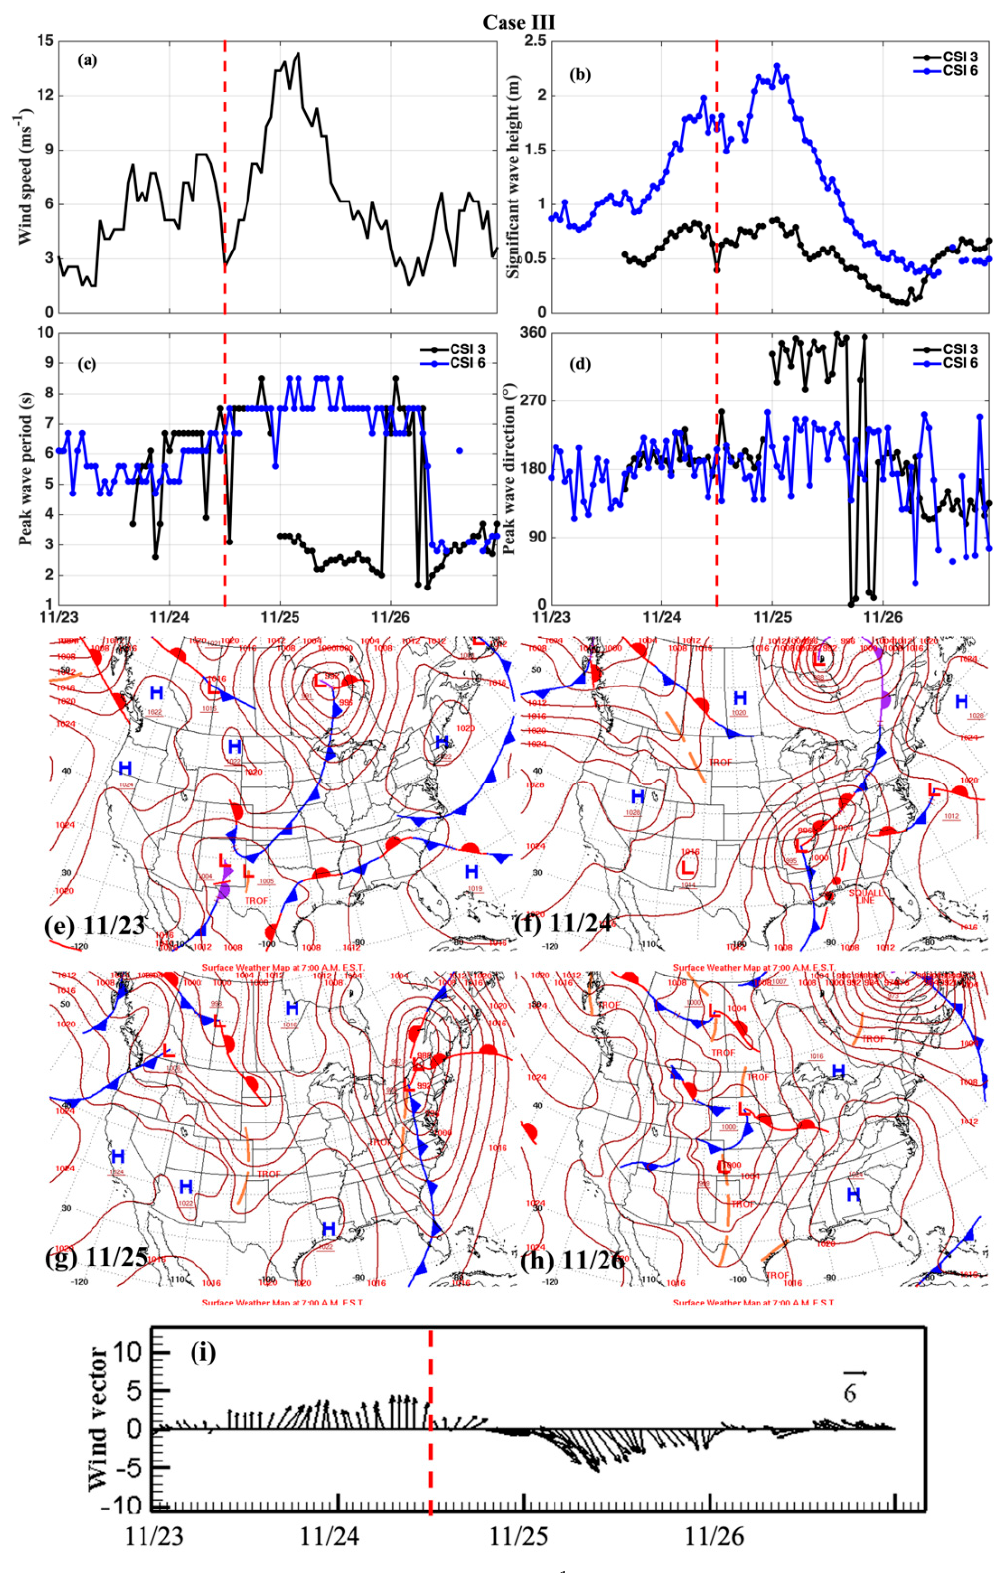
Figure 10. Case III: Time series of ( a ) wind speed (ms − 1 ) from the station WS, ( b ) significant wave height (unit: m), ( c ) peak wave period (s), ( d ) peak wave direction ( ◦ ), waves observed by CSI 6 are plotted in blue lines and observed by CSI 3 are plotted in black lines, ( e – h ) surface weather map on 12:00 UTC from 23 to 26 November and ( i ) wind vectors from the station WS. The red vertical dashed lines indicate the timing of the cold